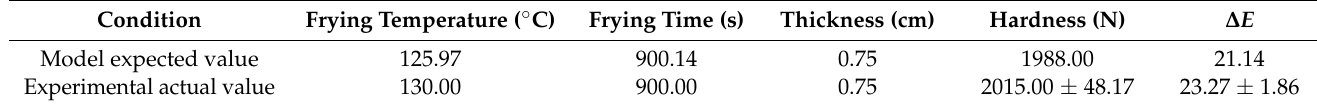
Table 4. Predicted and experimental values for the optimum